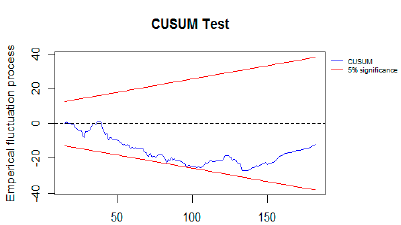
Figure 7. CUSUM test of natural yogurt.